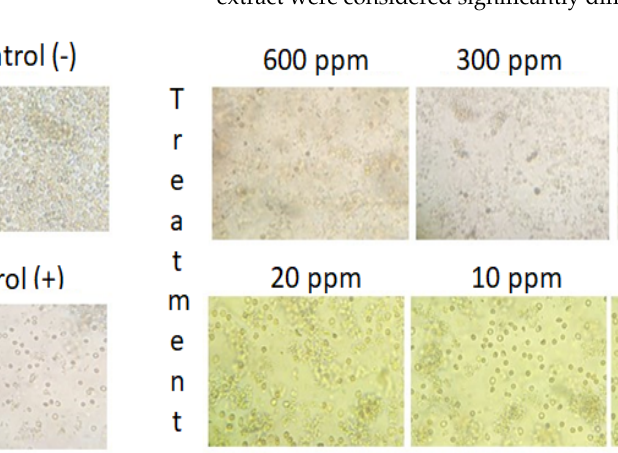
Figure 2. Qualitative analysis of the impact of B. cernua extract addition to malarial parasite ‐ infected erythrocytes. Control ( − ): erythrocytes; control (+): erythrocytes + P. falciparum ; treatment: erythro ‐ cytes + P. falciparum + methanol extracts at various concentrations (600 ppm, 300 ppm, 150 ppm, 100 ppm, 50 ppm, 20 ppm, 10 ppm, 5 ppm, 2 ppm, or 1 ppm).